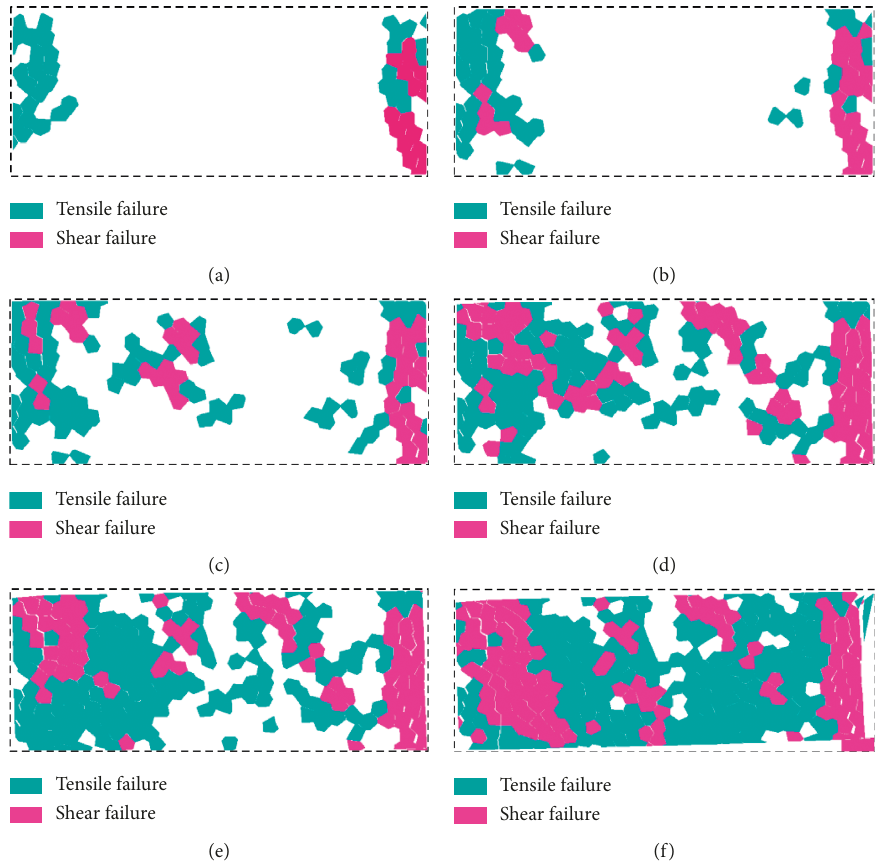
Figure 9: Evolution of tensile and shear cracks in pillar B. (a) After excavation of three rooms in #4 seam. Panel in #6 seam advancing by (b) 50m, (c) 80 m, (d) 90m, (e) 100m, and (f)